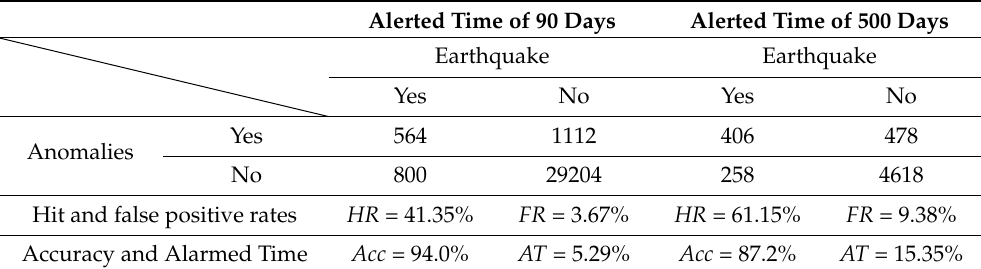
Table 2. Confusion matrices of the best Swarm magnetic field and electron density anomalies identified in the WSC concentrations that passed the statistical significance test (i.e., the ones with d ≥ 1.5 and n ≥